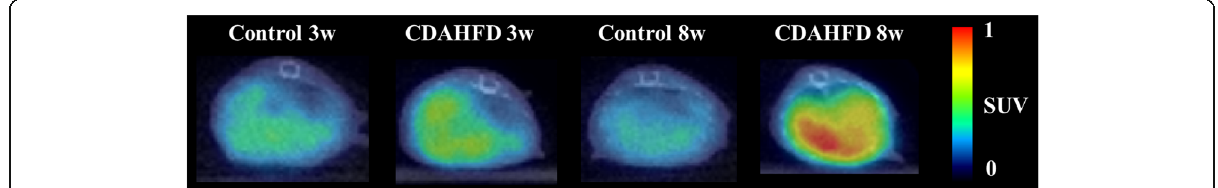
Fig. 2 Representative PET/CT fusion images in the livers of mice fed a control or choline-deficient, L -amino acid-defined, high-fat diet